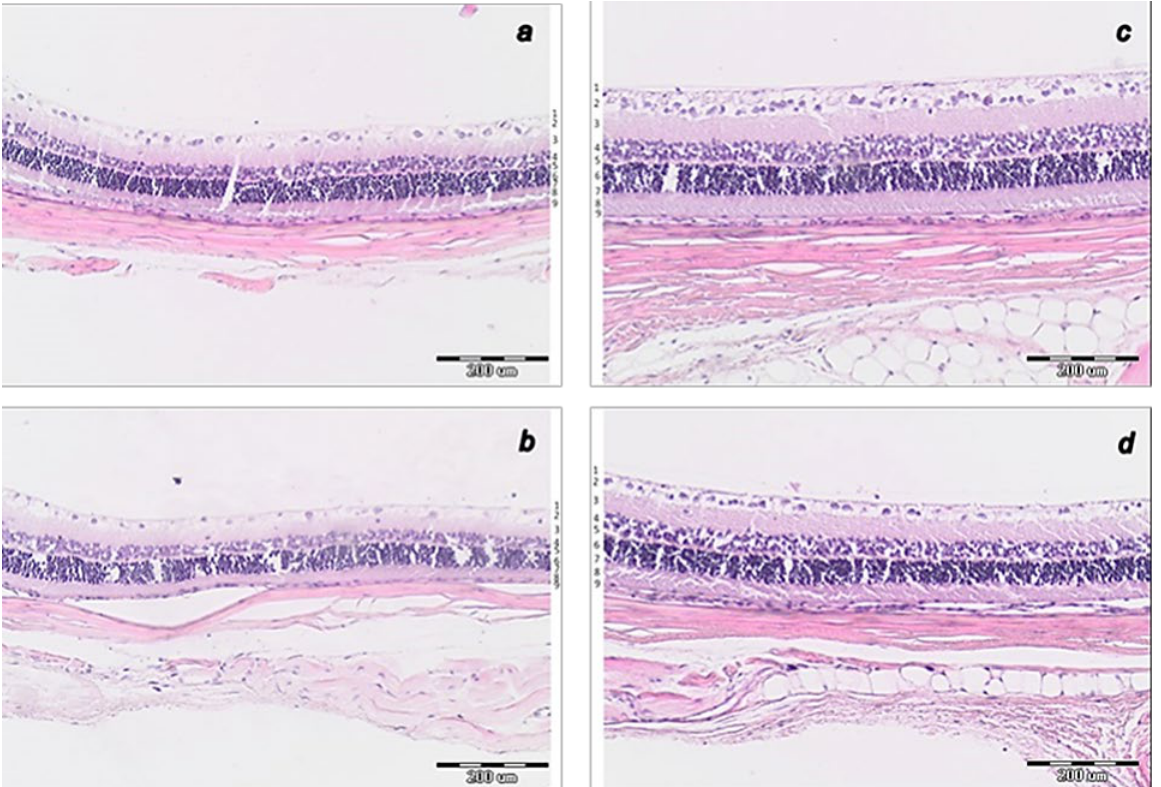
Figure 11. Histology of central part of transverse section of the retina 0.4–0.7 mm on the temporal side of the optic disc. ( a ). Rat retina after episcleral vein cauterization at week 4 in controls. ( b ). Rat retina after episcleral vein cauterization at week 6 in controls. ( c ). Rat retina after episcleral vein cauterization at week 4 in BPC 157-treated rats. ( d ). Rat retina after episcleral vein cauterization at week 6 in BPC 157-treated rats. (HE staining, magnification x20, scale bar 200 µm). Transverse section of the retina (0.4–0.7 mm on the temporal side of the optic disc) showing a strict difference in the retinal layers and full retina thickness in the rats that received saline and those that received BPC 157. More regular inner and outer nuclear layer and more regular distribution of ganglion cells, ( c ) than in control rats ( a ). At week 6, BPC 157-treated rats show the preserved thickness of the whole retina and also the inner plexiform layer and inner nuclear layer and its organization ( d ).